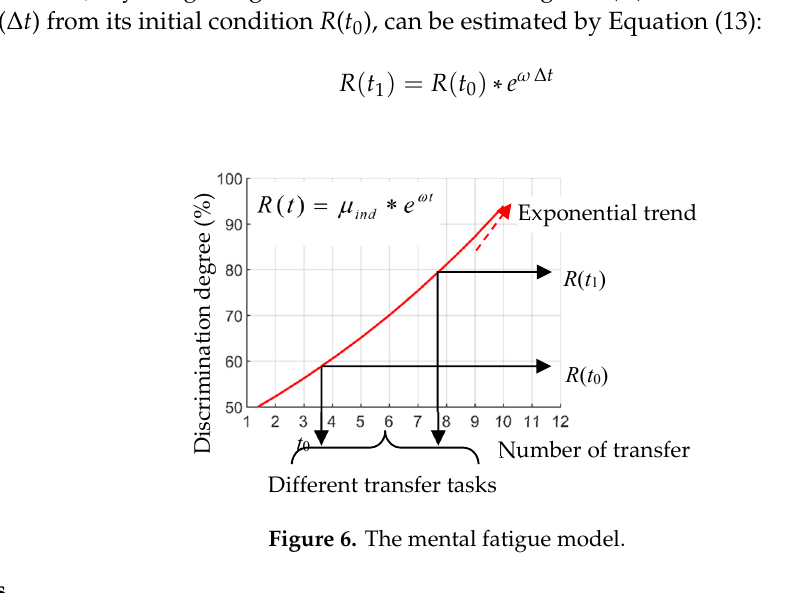
Table 1. The classification accuracies of the mean-peak combinations obtained from HbR signals and HbO signals. Mean and Peak